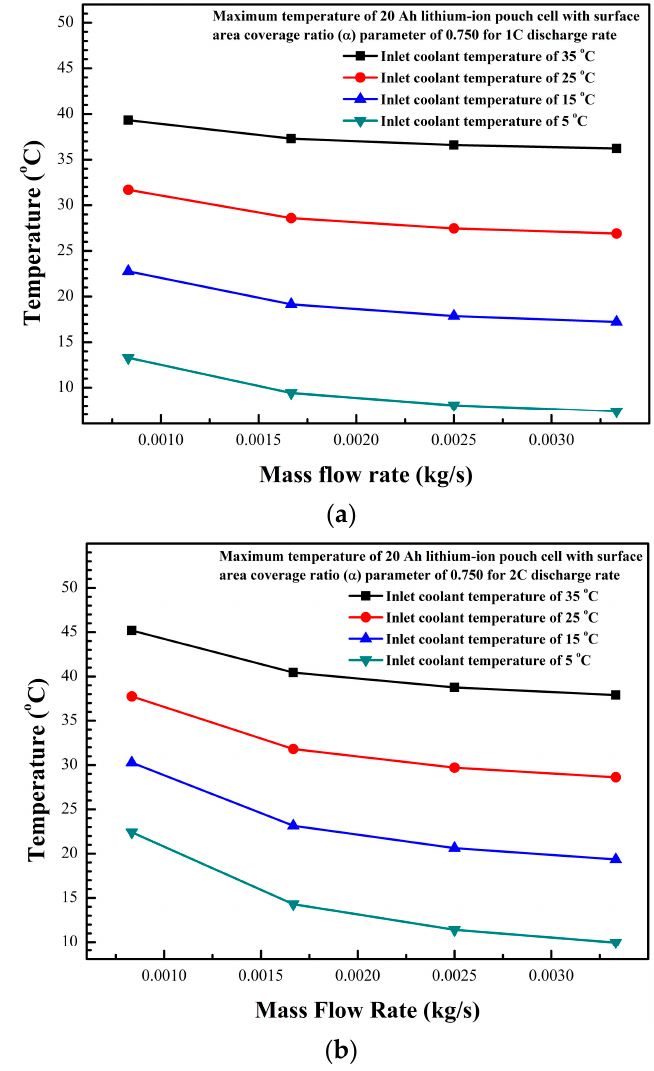
Figure 5. Maximum temperature of 20 Ah lithium-ion pouch cell with surface area coverage ratio ( α ) parameter of 0.750: ( a ) 1C; ( b ) 2C.